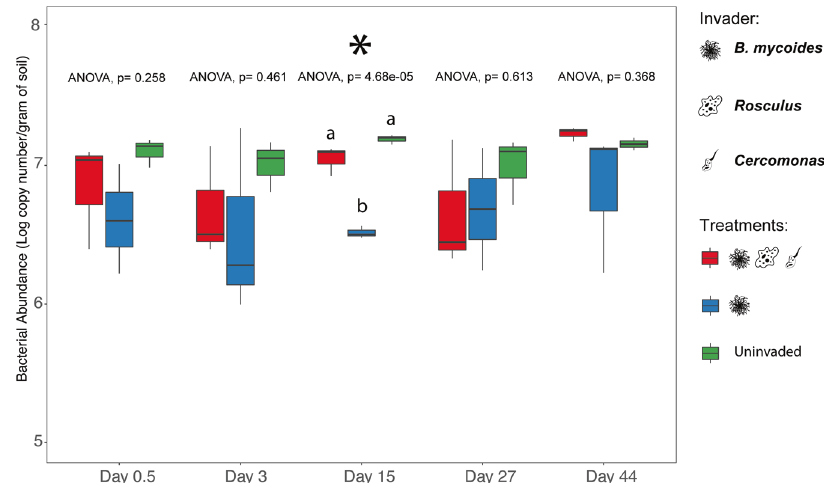
Fig. 3 Temporal dynamics of the total soil bacterial abundance between treatments in the Bacillus mycoides experiment. Values represent qPCR results in the log of 16S rRNA gene copies per gram of soil. Bars represent the standard error of the mean.